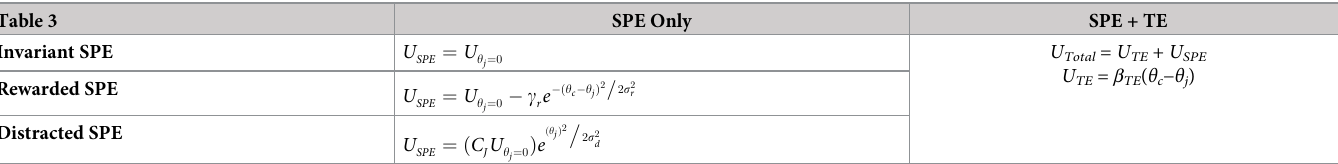
Table 3. Summary of models. Table 3 SPE Only SPE + TE Invariant SPE